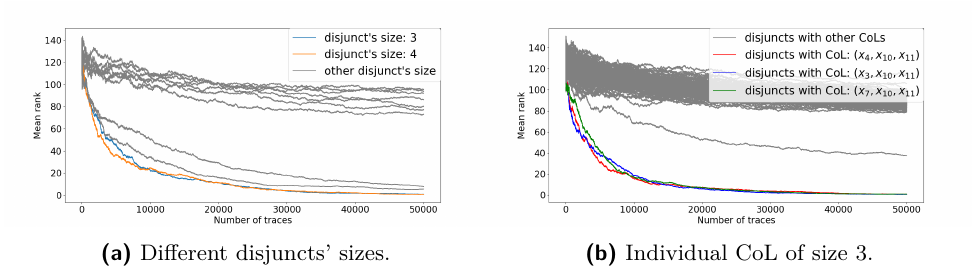
Figure 18: Guessing entropy after seiving disjuncts based on their sizes and each CoL individual of size 3 for AES_HD_ext.